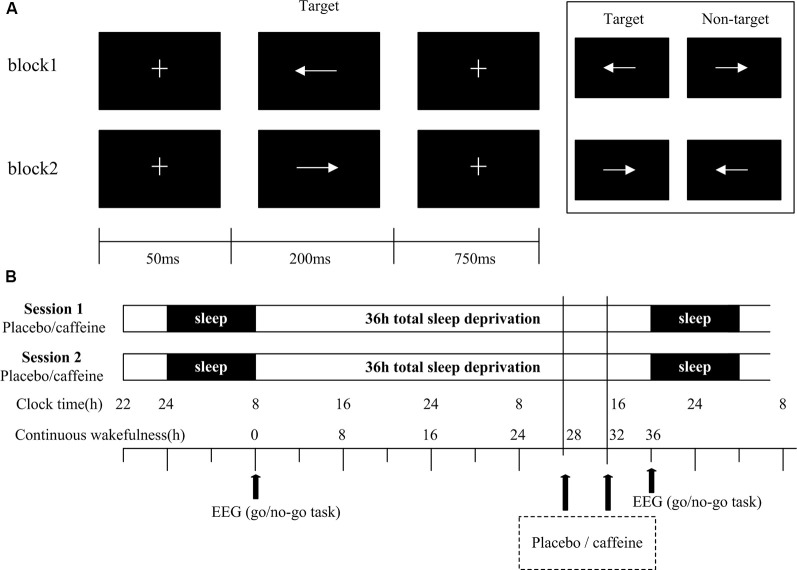
Go/No-Go task and study protocol. (A) Schematic representation of the Go/No-Go task, showing a single trial of two blocks. Each block consisted of 200 trials. (B) In the study protocol, subjects underwent two 36 h periods of total sleep deprivation (TSD). The black arrows indicate the time points of electroencephalogram (EEG) recordings and drug administration (400 mg of caffeine or placebo).